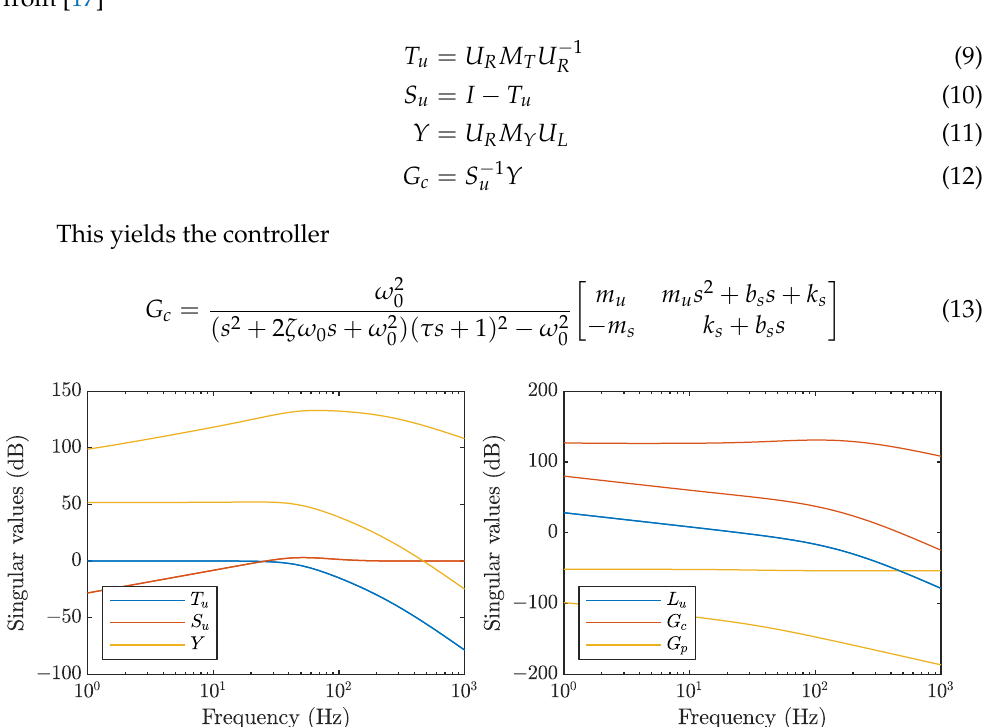
Figure 4. Singular values of the closed-loop transfer function T u , S u , and Y and of the return ratio L u , G c , and G p